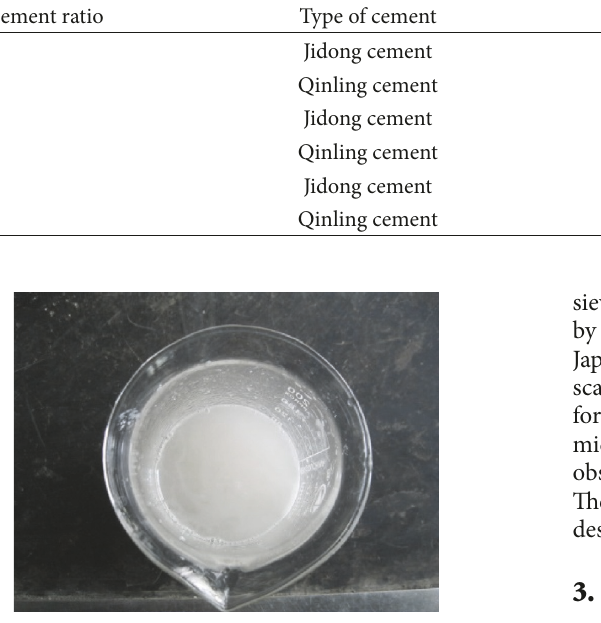
Figure 1: The new type of alkali-free liquid